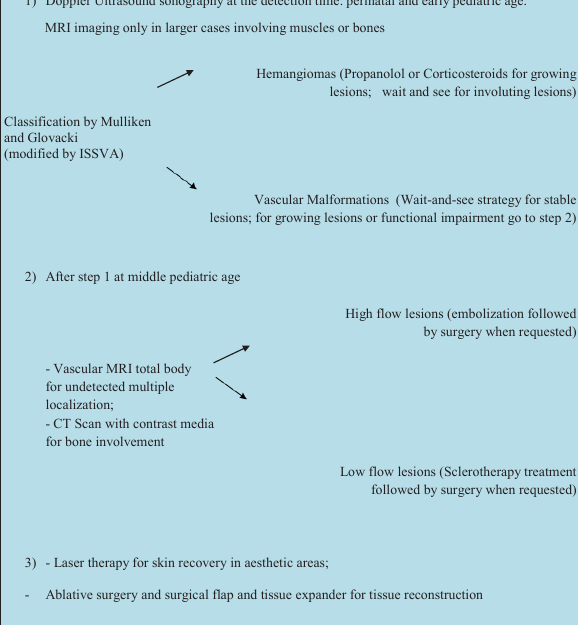
Table 1: Diagnostic-therapeutic scheme. 1) Doppler Ultrasound sonography at the detection time: perinatal and early pediatric age. MRI imaging only in larger cases involving muscles or bones